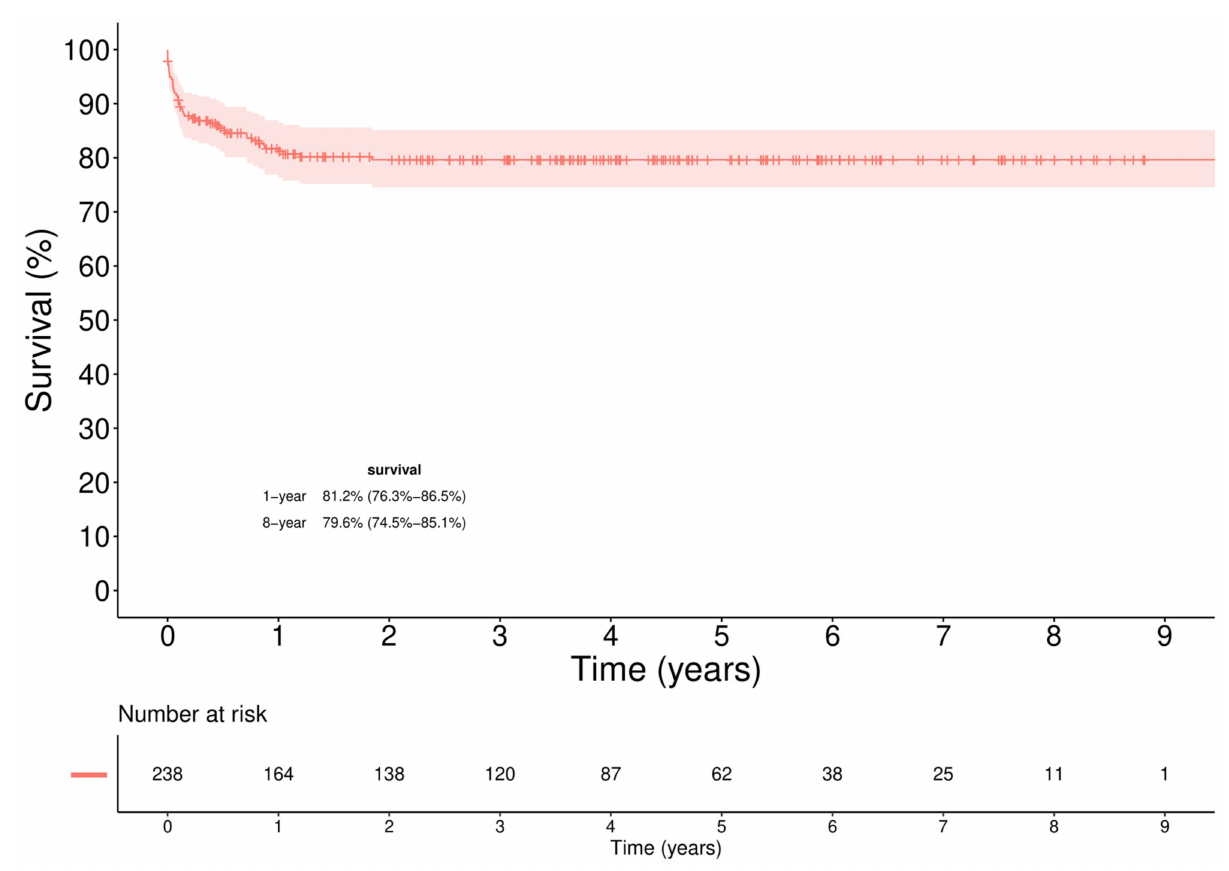
Figure 1. Overall survival in HTx population. Survival at 1 year was 81.2% (76.3–86.5%), at 8 years